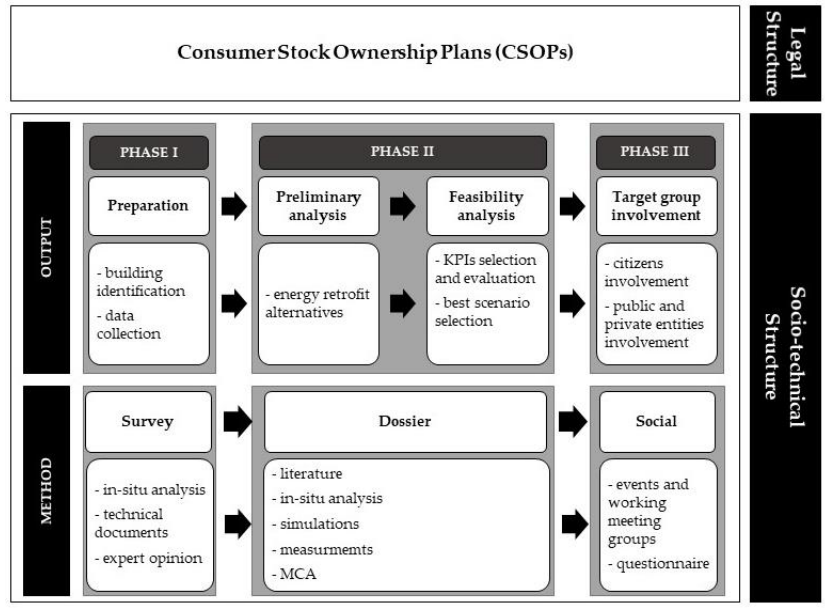
Figure2. Flow-work: differentstepsofwork. MCA:multi-criteriaanalysis;KPIs: Figure 2. Flow-work: different steps of work. MCA: multi-criteria analysis; KPIs: key performance indicators.